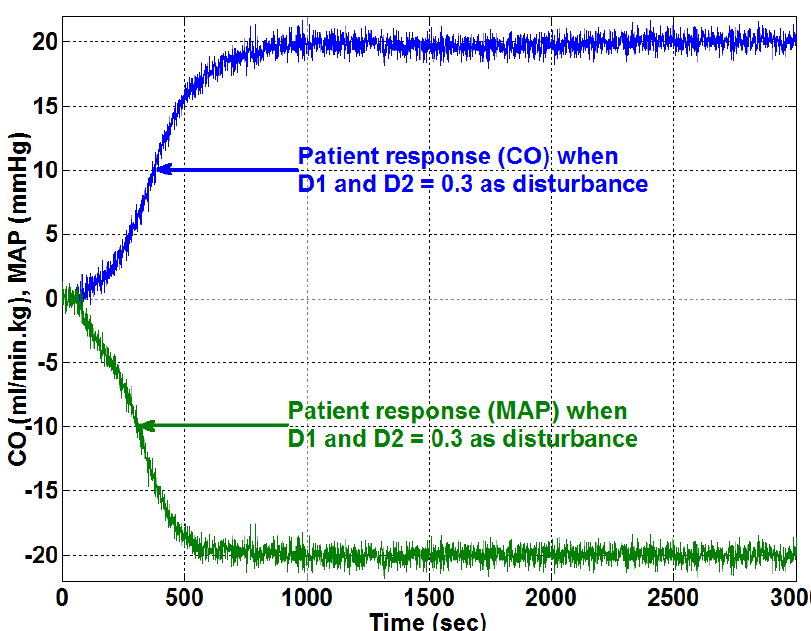
Figure 10: Nominal response with disturbance variance D1=D2=0.3 and set points +20 for CO and -20 for MAP